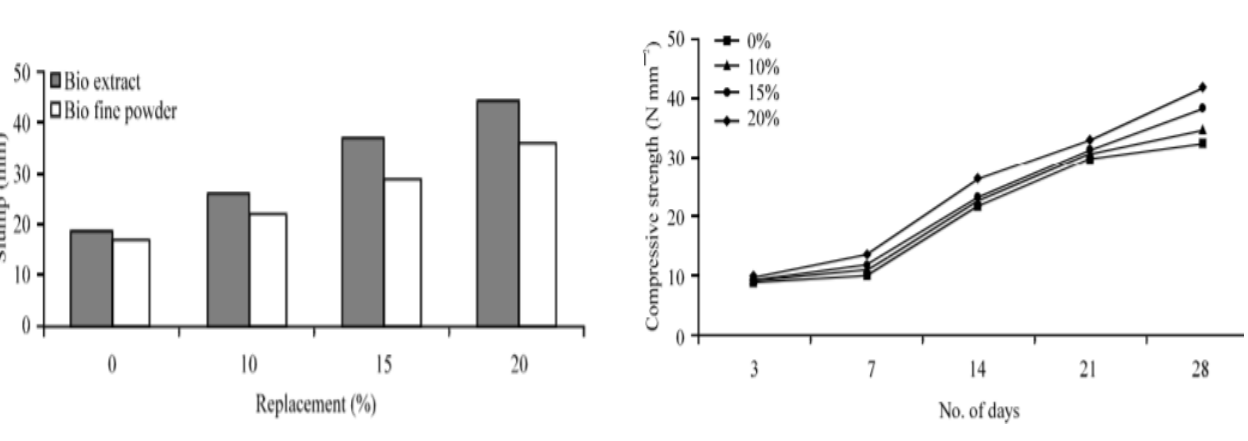
Figure 7. Test results water hyacinth effecting on concrete properties (Sathya et al.